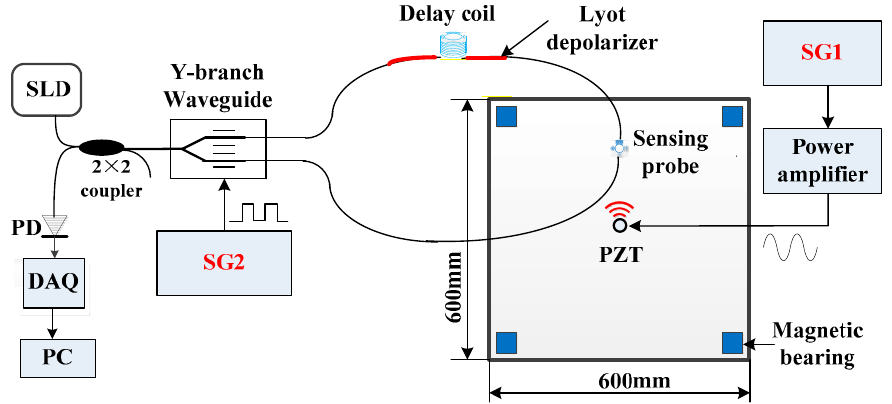
Figure 5. Experimental system of the optical fiber Sagnac AE sensor.